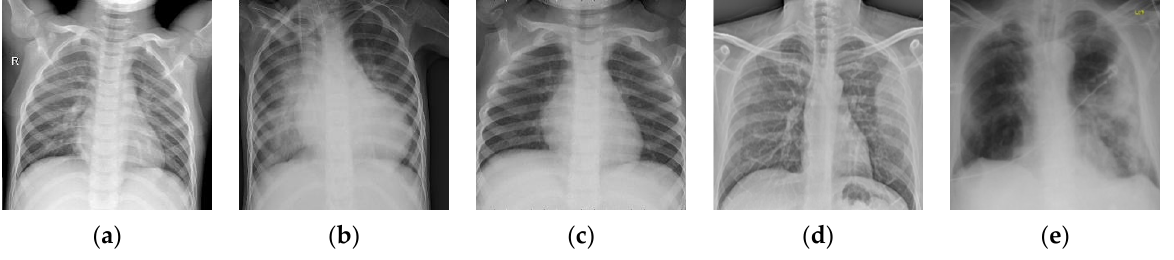
Figure 4. Examples of the Chest-1 dataset. ( a ) Normal; ( b , c ) pneumonia; ( d , e ) COVID-19.